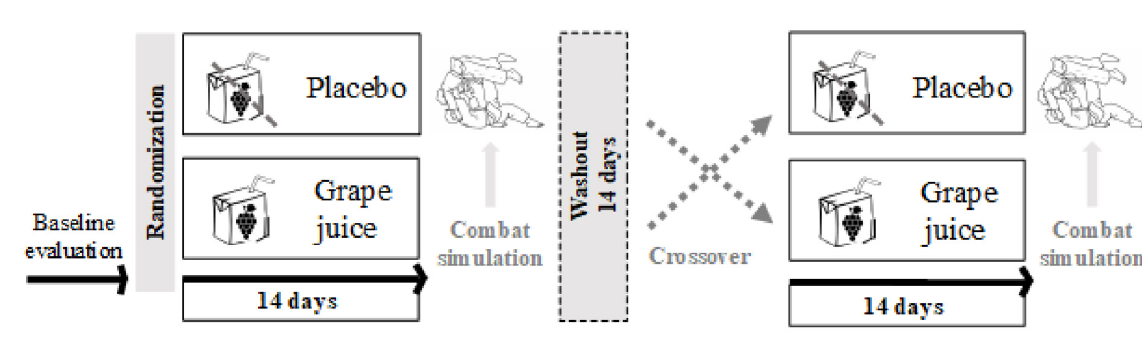
Figure 1. Experimental